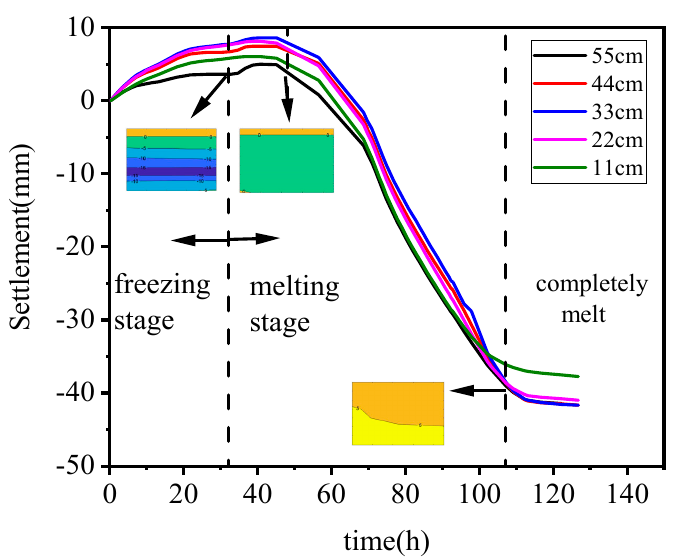
Figure 9. Frost heaving and thawing settlement.